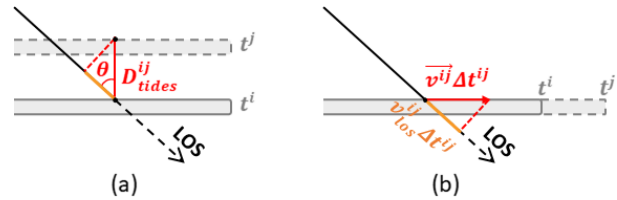
Figure 2. Displacements contributing to the interferometric phase over an ice shelf. (a) Change of vertical position caused by tides. (b) Horizontal ice flow motion. The ice shelf is represented at times t i and t j respectively by the continuous and dashed grey lines.